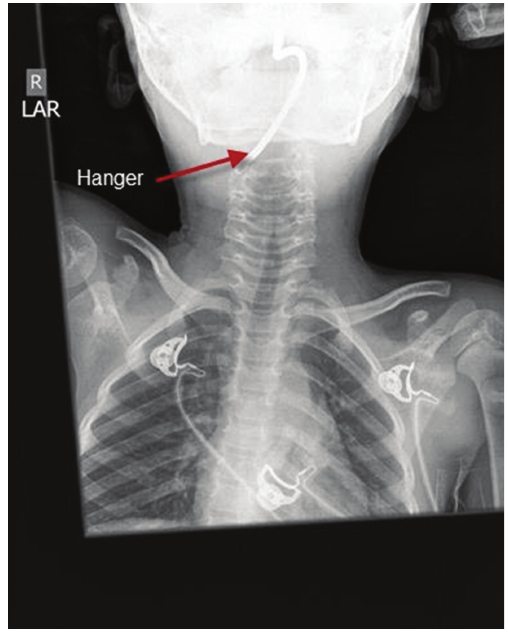
Figure 2: Anterior/Posterior neck X-ray again showing foreign